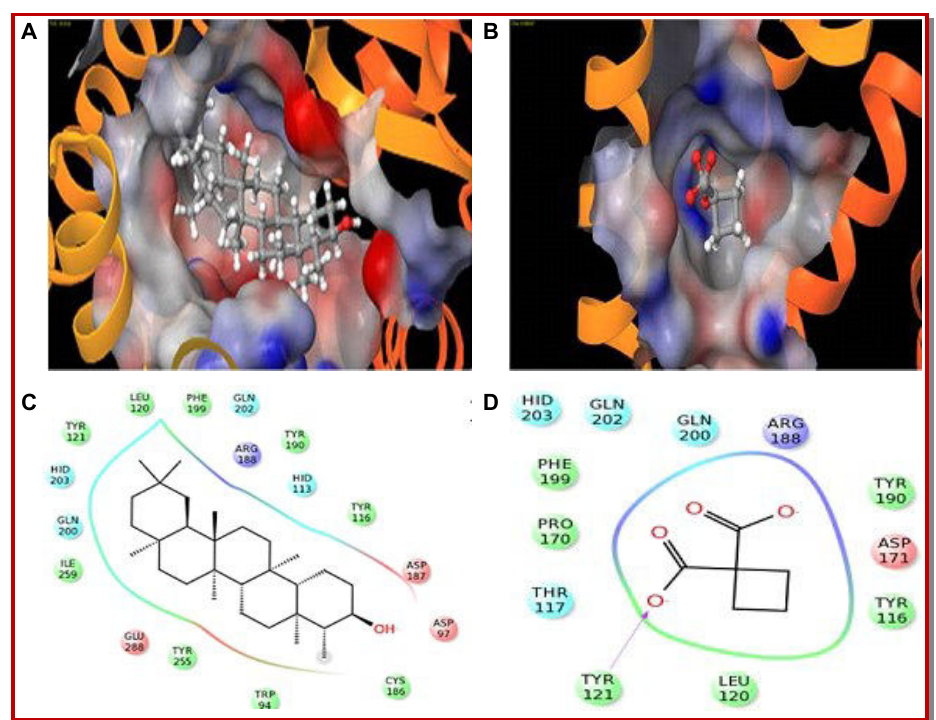
Figure 4: Docking complexes of CXCR4 protein with (A) epifriedelanol and (B) carboplatin generated by using Glide-XP module of Schrodinger suite are shown in this figure. The proteins, ligands and binding pockets are represented in ribbon, sticks and sur- face models, respectively. Residues of the CXCR4 that are within 4 Å proximities to the (C) epifriedelanol and (D) carboplatin are illustrated in 2D graphics. Dotted lines denote ‘Hydrogen bonds’ between the corresponding